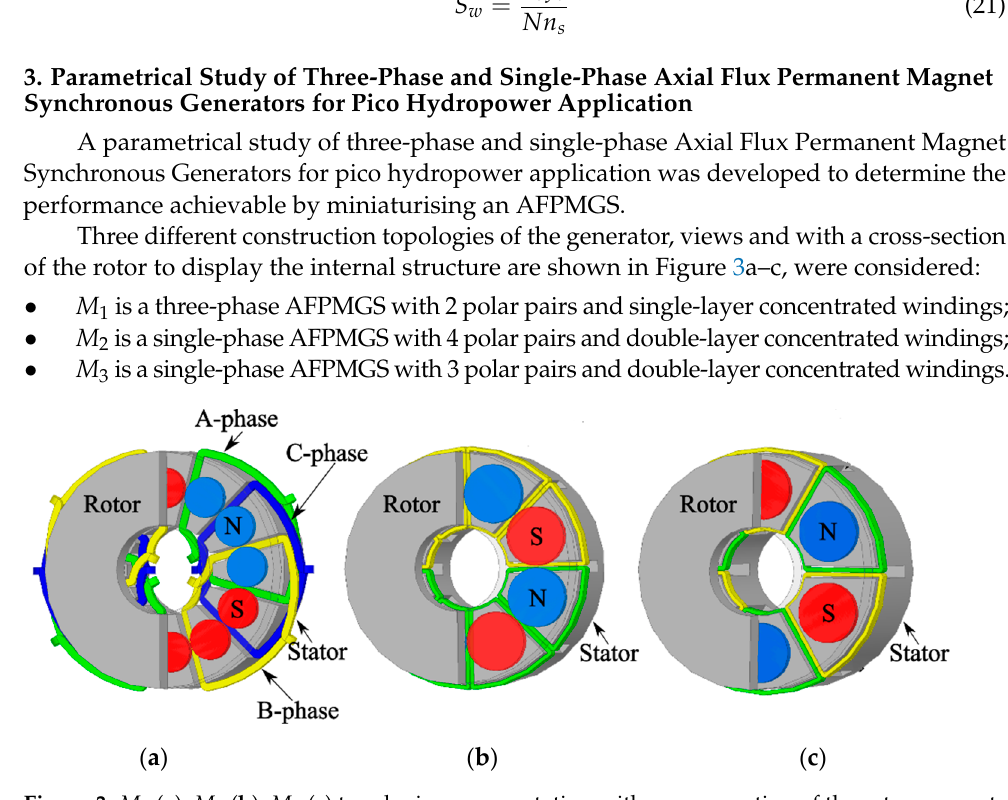
Figure 3. M 1 ( a ); M 2 ( b ); M 3 ( c ) topologies representation with a cross-section of the rotor, magnets and coils.